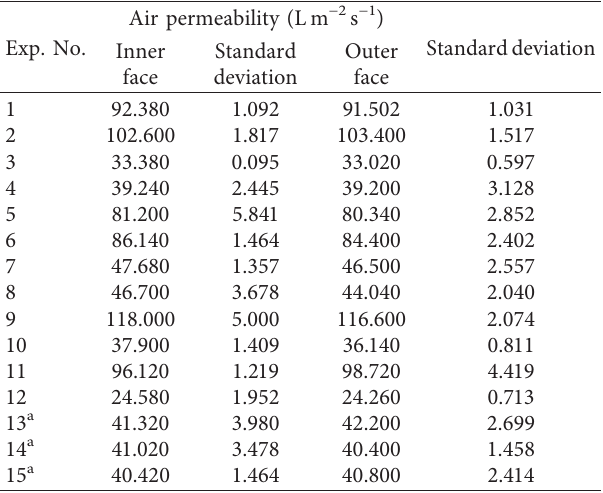
“a” indicates the design central